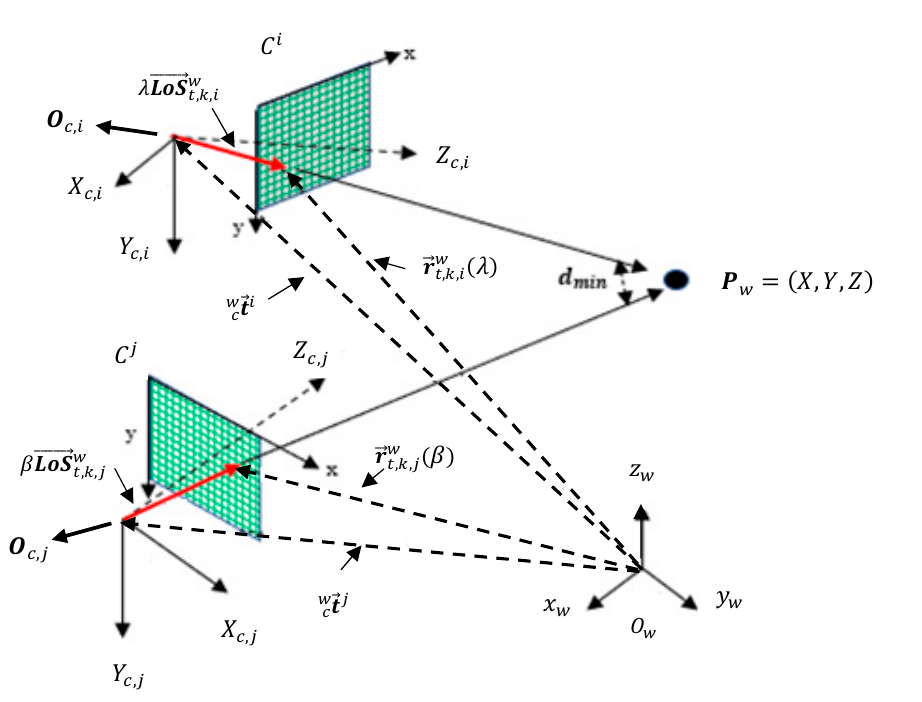
w w → → ( λ ) and ( β ) . The tolerance r r t , k , i t , k , j w w → → LoS LoS t , k , i and t , k , j point at the same target.